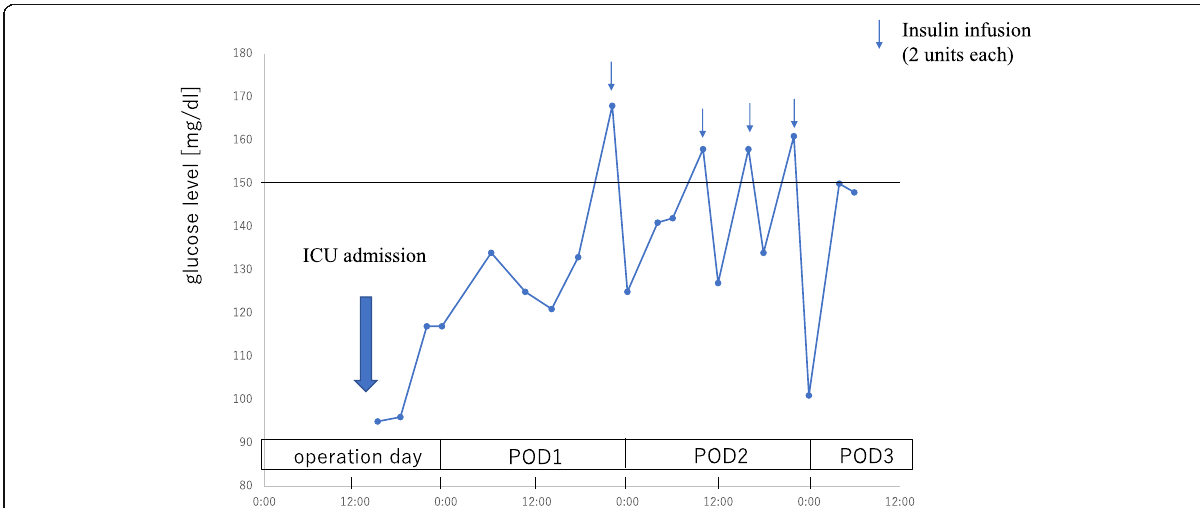
Fig. 3 Postoperative glycemic change. Insulin infusion was administered in case the blood glucose levels were over 150 mg/dl. ICU intensive care unit, POD postoperative